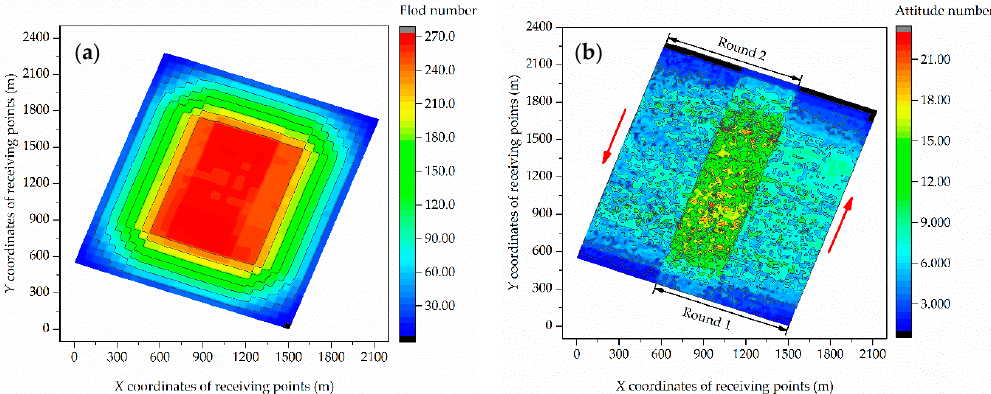
Figure 3. Fold number and attitude number on each receiving point. ( a ) fold number on each receiving point, ( b ) attitude number on each receiving point.